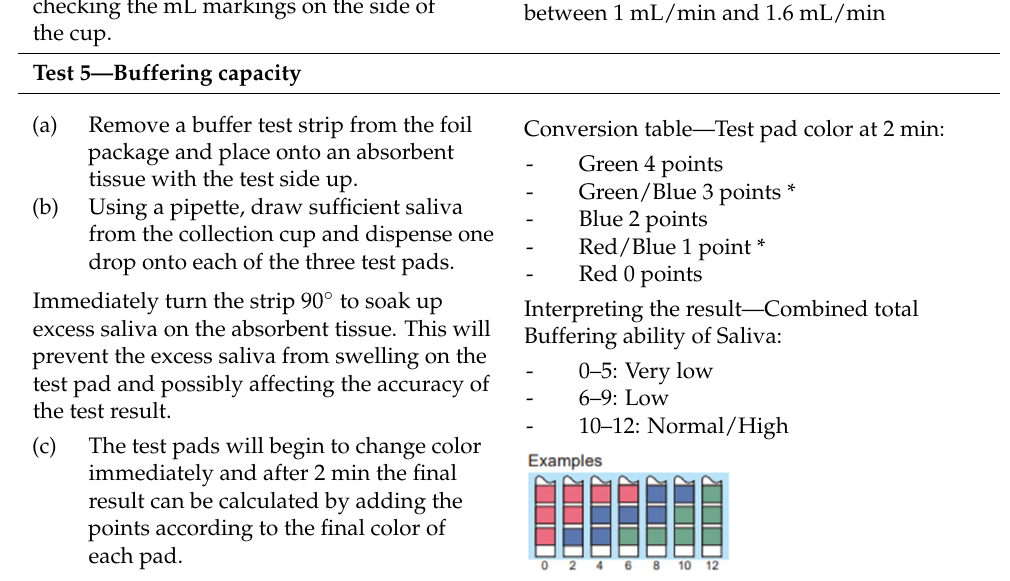
Conversion table—Test pad color at 2